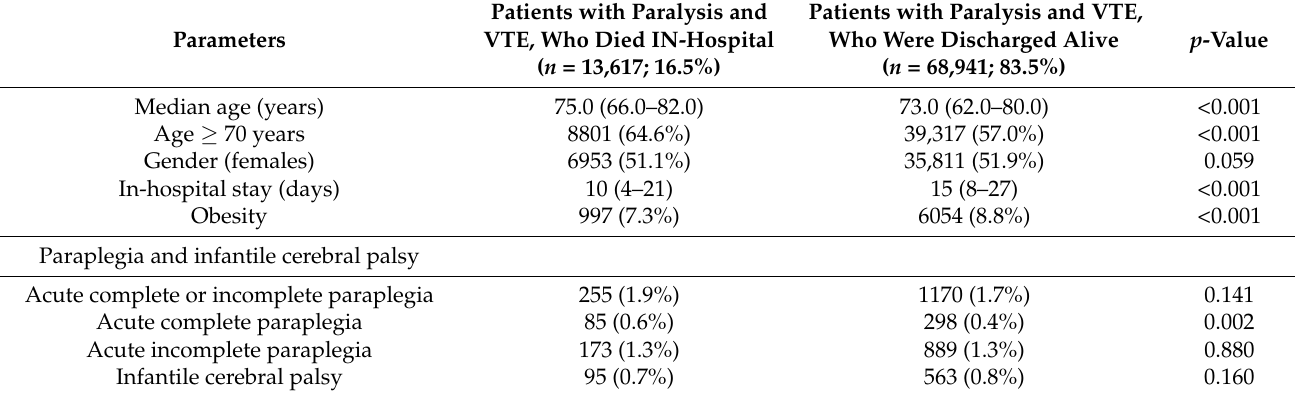
Table 3. Characteristics, medical history, presentation, treatments and adverse in-hospital events of 82,558 patients with paralysis (ICD codes G80-G83) in co-prevalence with venous thromboembolism (ICD-codes I26, I80, I81, I82) and stratified for in-hospital